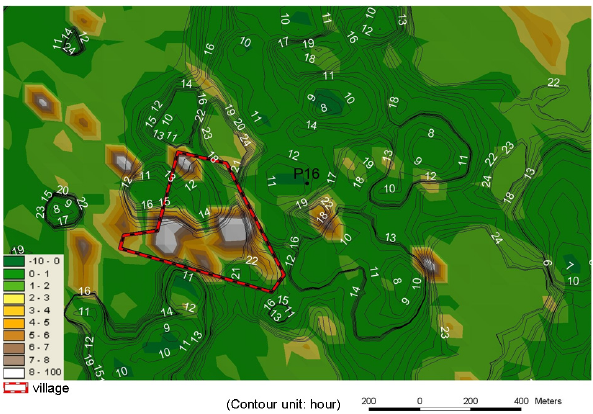
Fig. 12. Topography around P16 with the inundation contours of 20-cm depth advancing with elapsed time (by hour) in Typhoon Sepat.